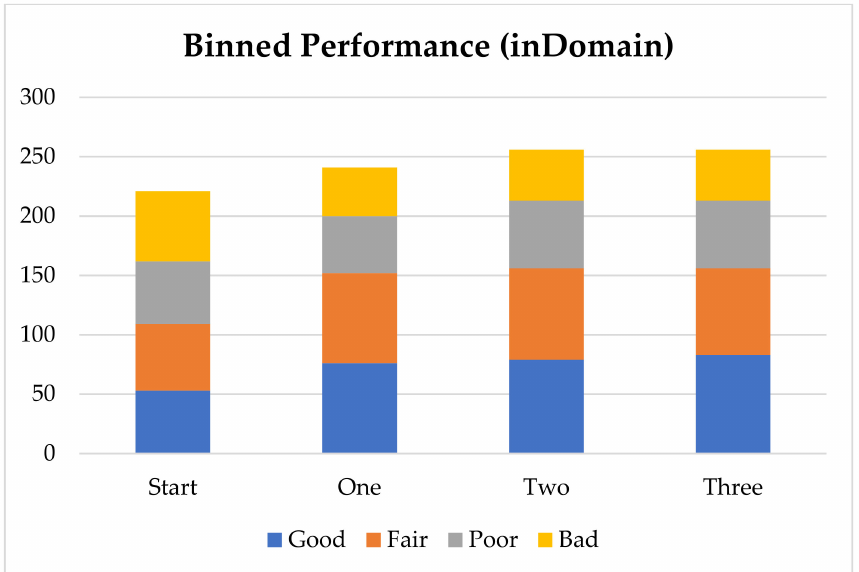
Figure 1. Binned performance stats by count ( top ) and by percentage ( bottom ) (if the absolute error is less than 1 pK a unit then “Good”, 1 < Fair < 2, 2 < Poor < 3, Bad > = 3).